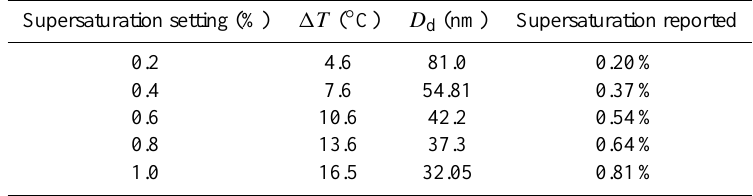
Table A1. (NH 4 ) 2 SO 4 DMT CCN calibration information for a 0.5Lmin − 1 flow rate.